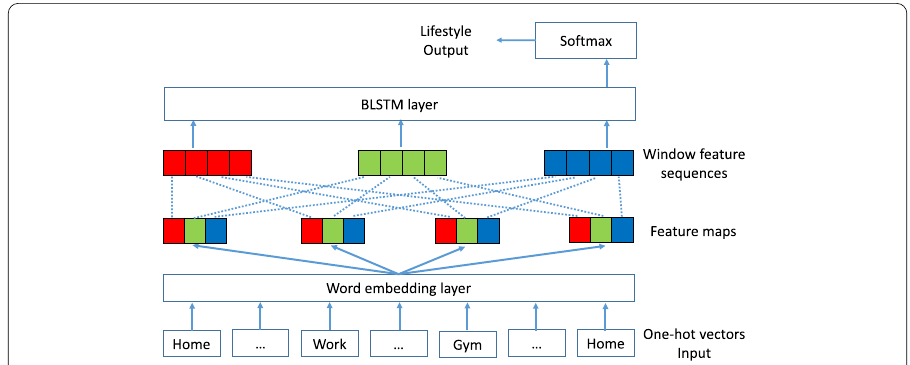
Figure 10 Predicting with CBLSTM. The CBLSTM model for predicting a lifestyle to trajectory. A one-hot vector has zeros for all trajectories except the specific trajectory (which is one). Each feature in a feature map is represented in a different color (could have more than three